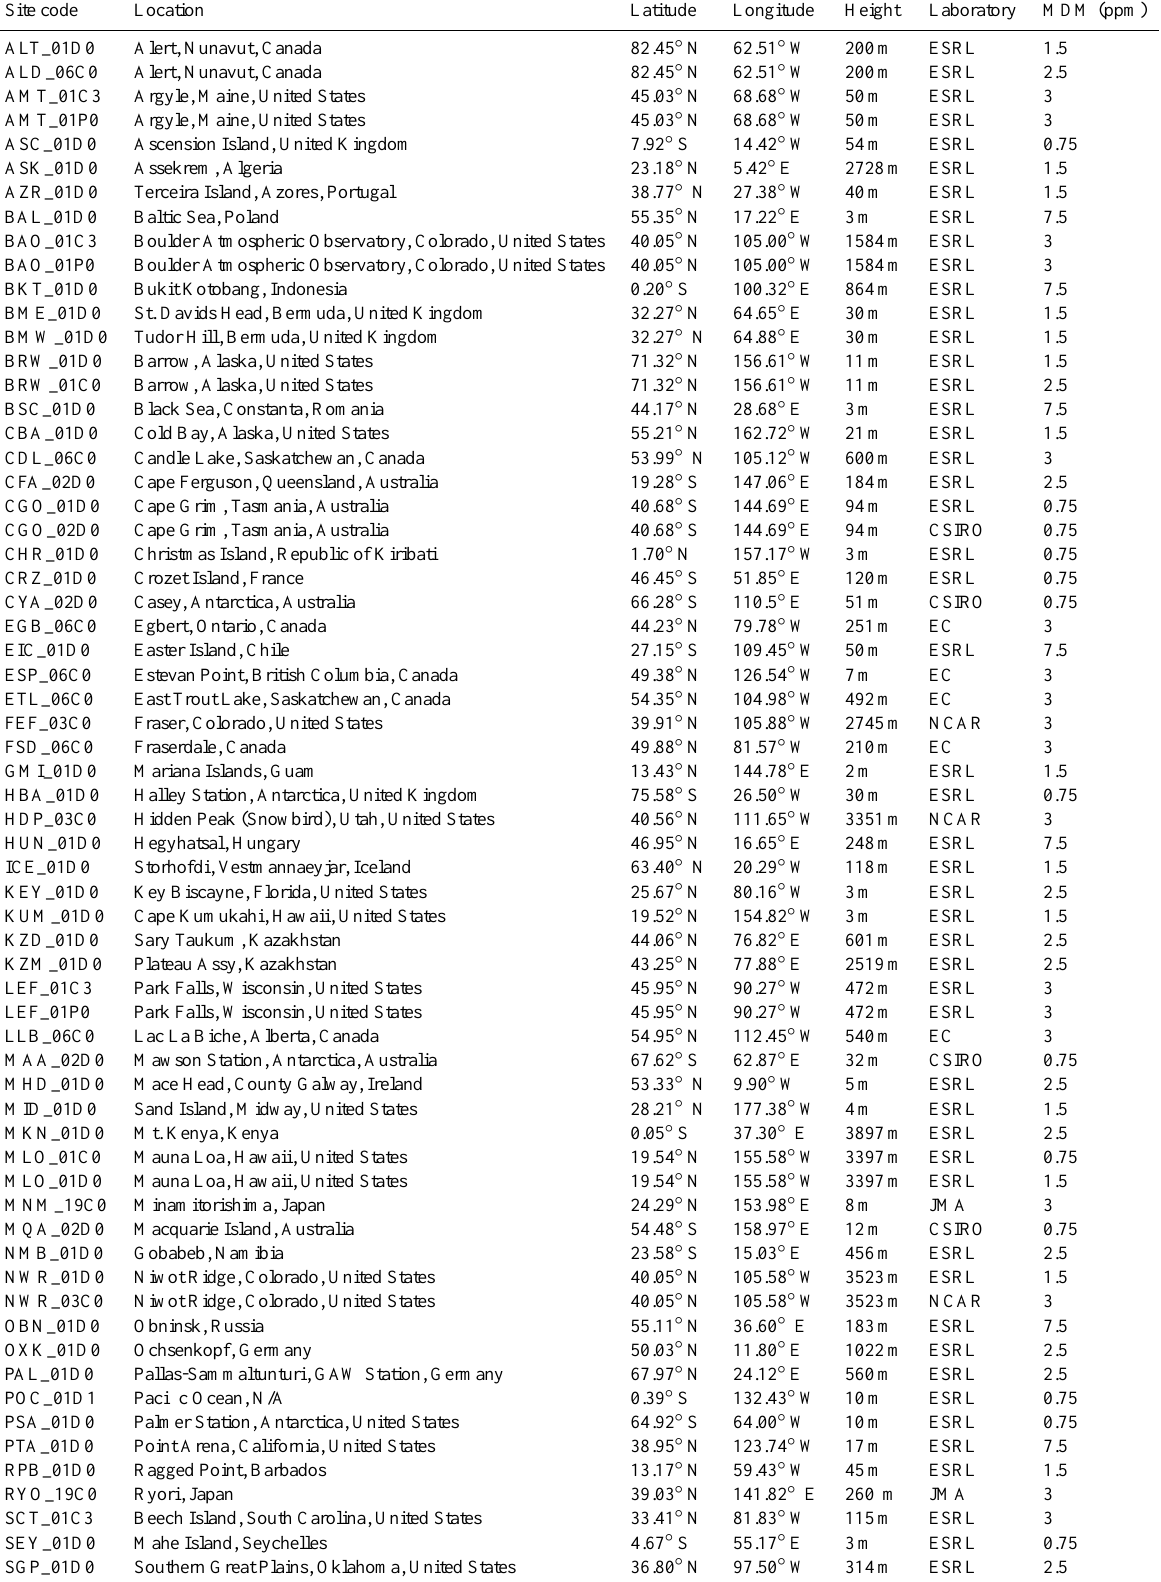
Table 1. Information on the observation sites used in this study. MDM represents the model–data mismatch, which is the observation error. Site